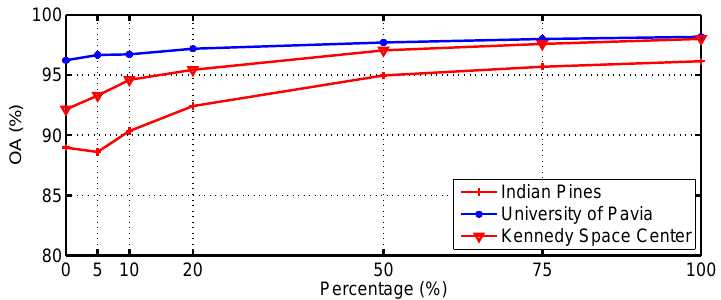
Figure 9. OA as a function of the number of anchor samples.